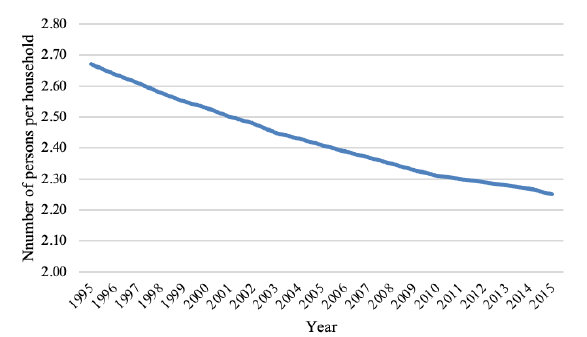
Figure 5 . Trend of the number of persons per household in the study area (Osaka Prefecture, 2019).